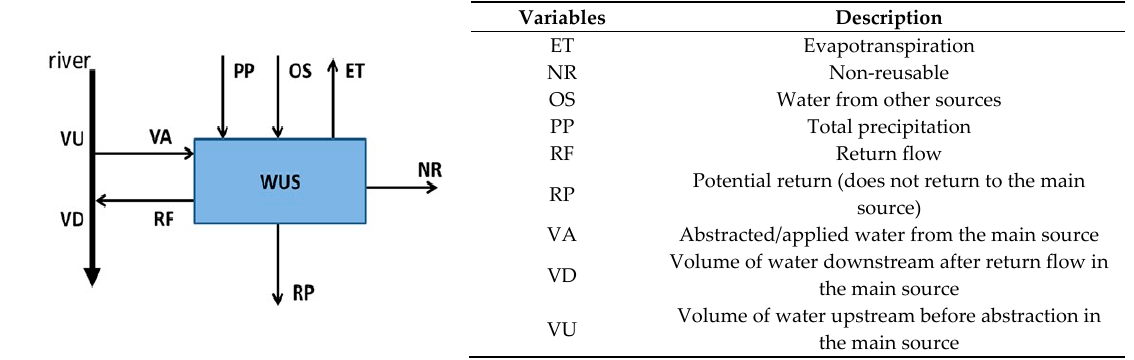
Figure 2. Basic water flow path types (WaTs) of a water use system (WUS) and its description.